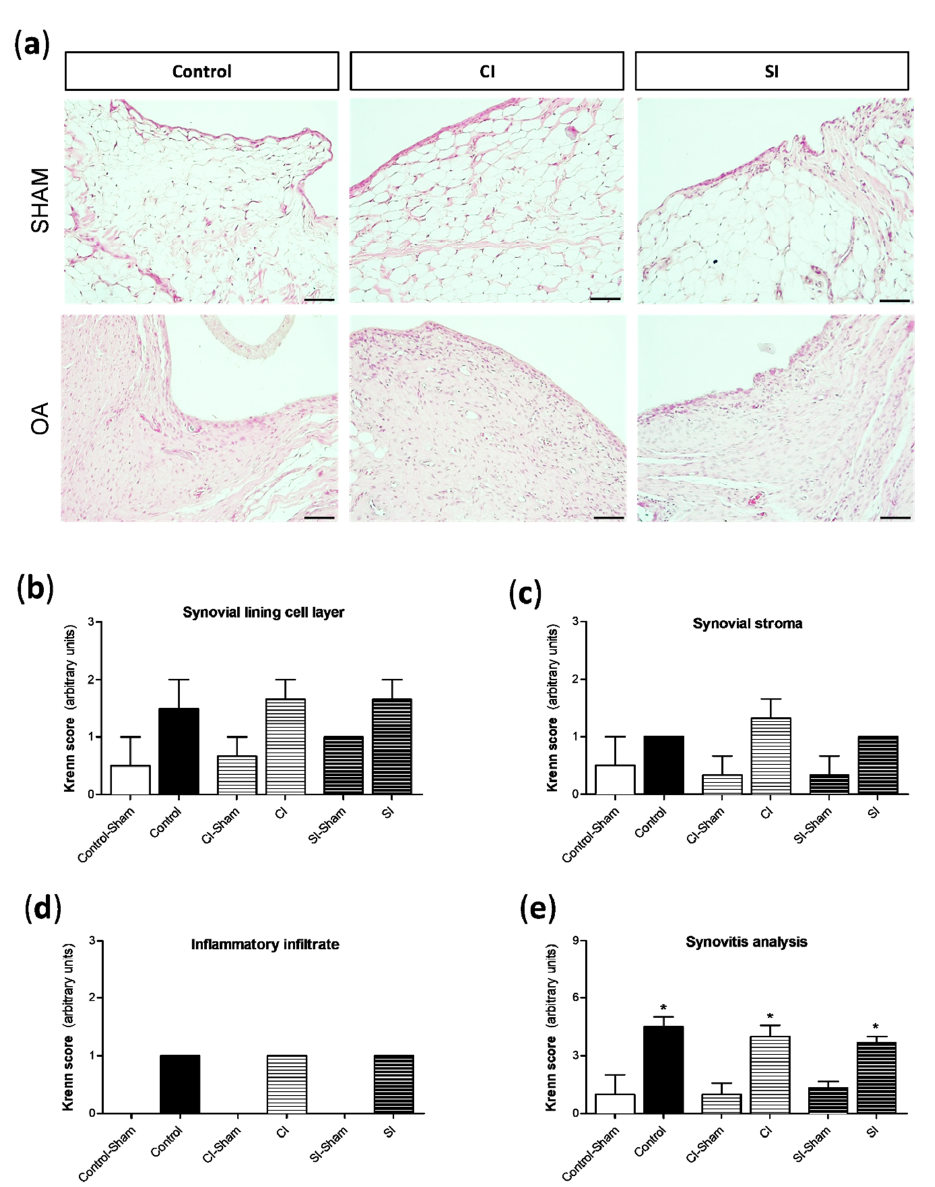
Figure 4. Histological analysis of synovial tissue. Pathological responses in the synovial tissue were evaluated by a semi-quantitative Krenn score, as previously indicated in the Materials and Methods section. ( a ) Representative images of synovial sections stained with hematoxylin and eosin from each group of the study, showing synovium in the medial compartment of the right knee (sham surgery) and left knee (OA surgery). Analysis of the semi-quantitative score of the following pathological alterations in the synovial tissue: number of lining cell layers ( b ), proliferation of the subintima tissue ( c ), and infiltration of inflammatory cells ( d ). ( e ) The sum up of the pathological changes in the tissue is shown. Values are mean ± SEM ( n = 3 independent animals for each condition). * p ≤ 0.05 vs. the respective sham-operated joint. Control, non-treated; CI, control injection; SI, H 2 S donor injection. Scale bar = 50 µm.